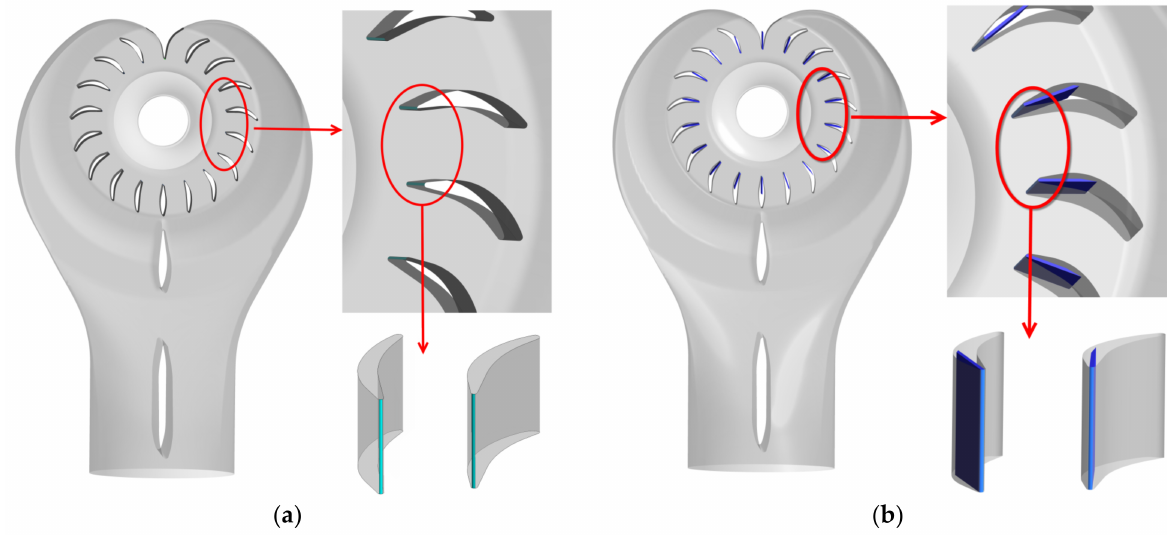
Figure 4. The ( a ) trailing edge blowing scheme and ( b ) self-induced slot